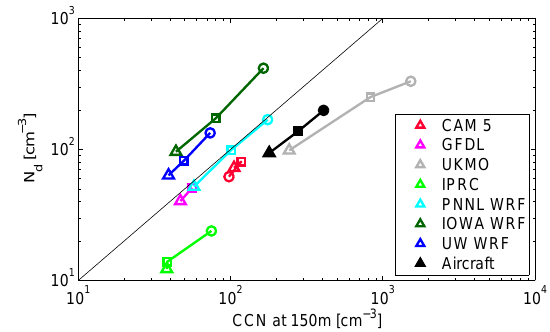
Figure 14. Mean cloud droplet concentration versus CCN (0.1% supersaturation) at 150m for models and aircraft observations at 20 ◦ S. Values are binned from 80 to 85 ◦ W (triangles), 75 to 80 ◦ W (squares) and 71 to 75 ◦ W (circles). A one-to-one line is also plot-